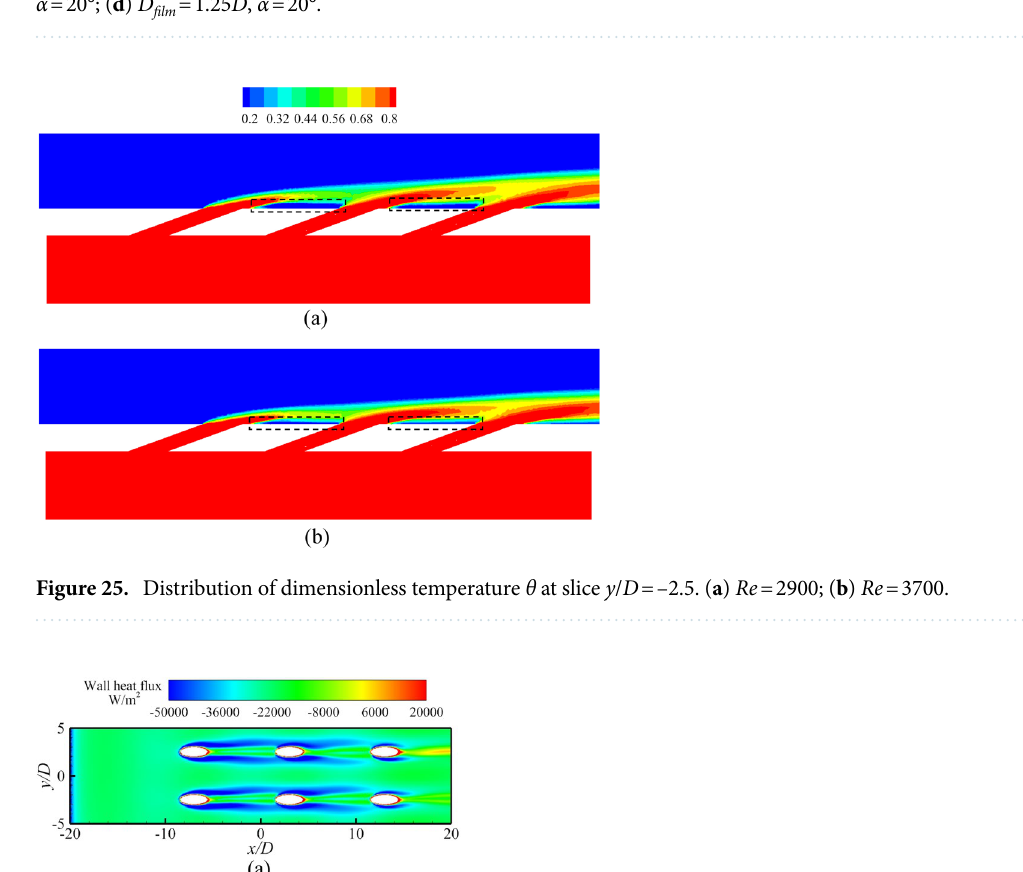
Figure 24. Contours of h g / h i for film hole model. ( a ) Ref-case #1; ( b ) D film = 1.0 D , α = 30°; ( c ) D film = 0.75 D , α = 20°; ( d ) D film = 1.25 D , α = 20°.